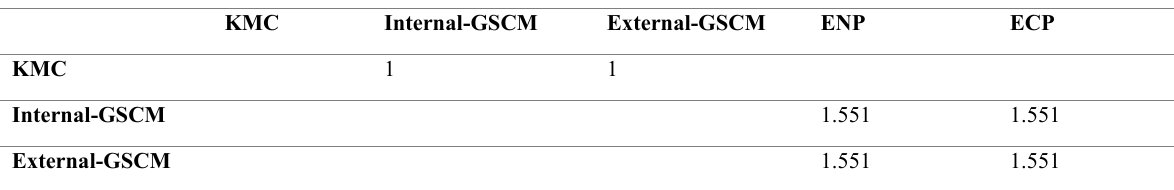
Table 2: Variance inflation factors